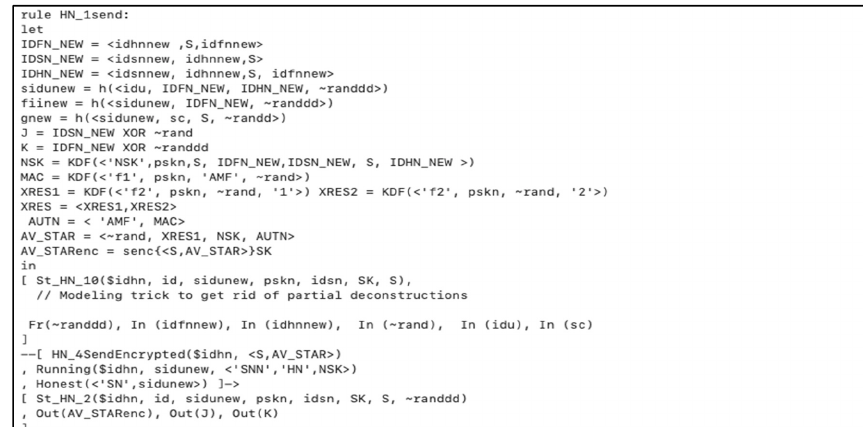
Figure 8. HN – FN authentication and new parameters creation.